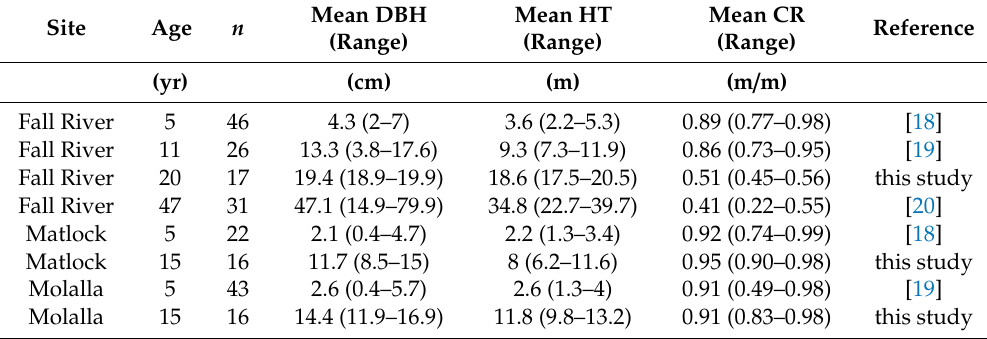
Table 2. Site ages, sample size, mean diameter at breast height (DBH), height (HT), and crown ratio (CR) (min-max) for the biomass data included in this